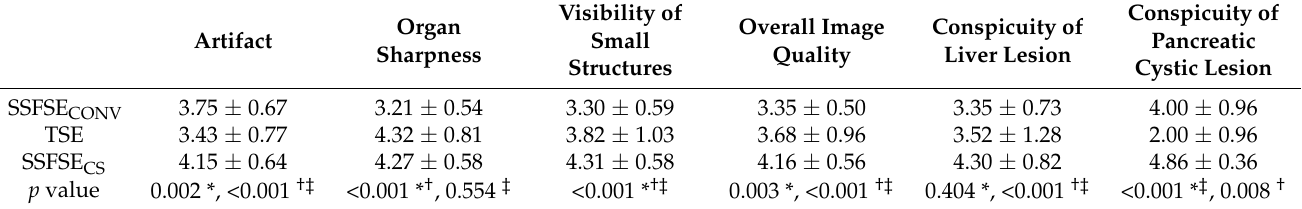
Table 2. Results of subjective image analysis using five-point evaluation scale system for each MRI